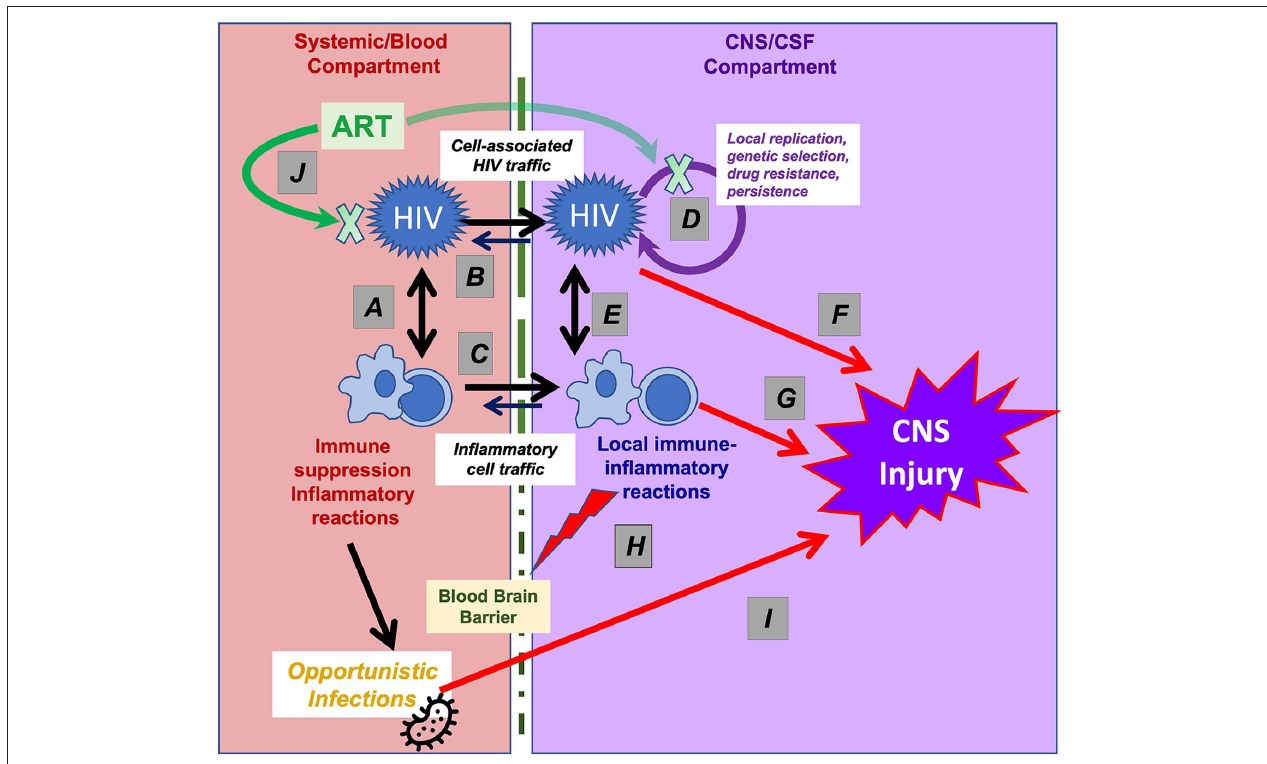
FIGURE 1 | Interactions of HIV and immune-inflammatory responses in systemic and CNS infection. This simplified schematic outlines the systemic and CNS viral-immune interactions that determine the immunopathogenesis of CNS injury. Systemic interactions (shown in the left part of the figure) establish the foundation for CNS vulnerability that are partly echoed by interactions within the CNS (right part of the figure), though with important differences. (A) HIV targets CD4 + T lymphocytes (and to a lesser degree myeloid cells) in which viral replication both sustains viremia and establishes long-term viral persistence, leading to gradual T-cell loss and immunosuppression and to lifelong infection. Virus-induced T-cell activation, in turn, enhances viral replication and dissemination. (B) Systemic viremia is the source of CNS HIV infection, beginning early in infection, likely mainly via infected T cells that migrate through the blood-brain barrier (BBB, depicted by vertical dotted line). (C) Cells important to the CNS inflammatory response also derive from blood sources; these include CD4 + and CD8 + T cells and macrophages that elaborate cytokines and other signaling and toxic molecules that contribute to the compartmentalized CNS inflammatory response within the CNS and are reflected in CSF. (D) HIV can replicate locally within these migrating CD4 + T cells and macrophages sustaining a genetically independent infection and perhaps establishing a longer-lived second viral reservoir within the CNS. (E) The interaction of the local HIV infection with “imported” inflammatory cells and native CNS cells (including astrocytes and microglia) establish an independent inflammatory milieu that evolves over the course of disease and is particularly heightened in HAD/HIVE. (F) Both HIV gene products and (G) host inflammatory reactions likely contribute to ‘indirect’ CNS injury. (H) inflammatory reactions can disrupt the blood-brain barrier, further exacerbating this injury. (I) CNS OIs may involve a similar pathway, first with loss of systemic immune surveillance allowing entry or activation of pathogens that then invade the CNS and cause neurological disease by direct injury or through a local inflammatory response. (J) ART reverses or mitigates all of these processes. By suppressing HIV replication, treatment fosters a variable degree of CD4 + T cells restoration and partial reversal of these pathological processes. Abrupt restoration of immunity may lead to robust local inflammation and the immune restoration inflammatory response (IRIS) with exacerbation of neurological symptoms and signs.